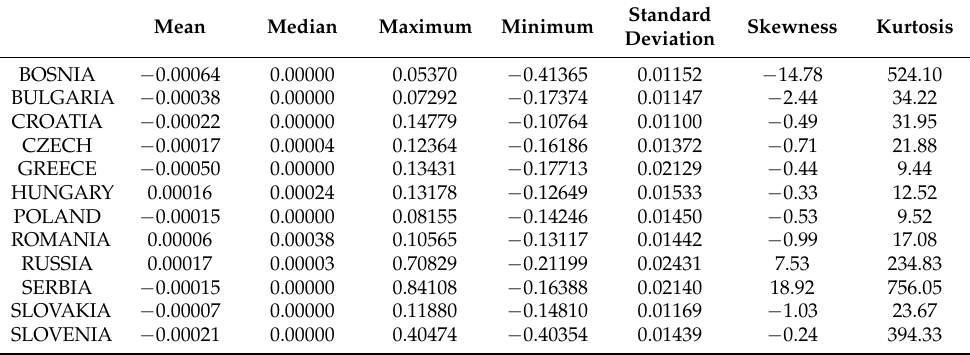
Table A1. Descriptive statistics for return series in the entire